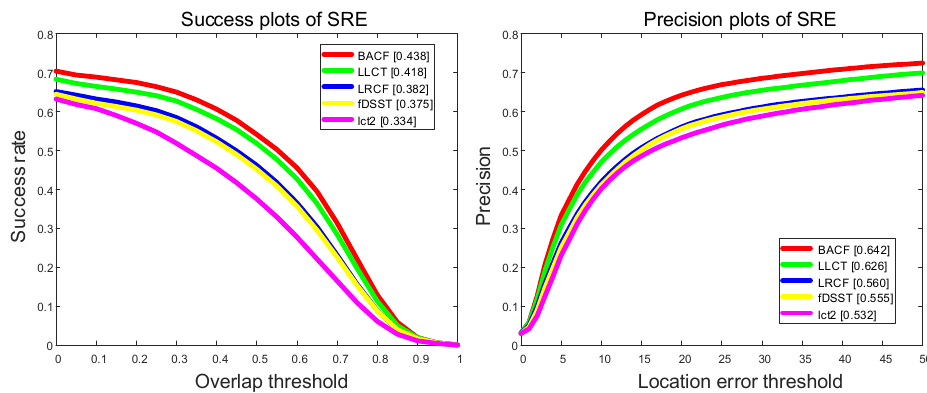
Figure 8. Quantitative results: the overlap success rate and distance precision for a threshold of 20 pixels. Table 2. The average precision on UAV123.